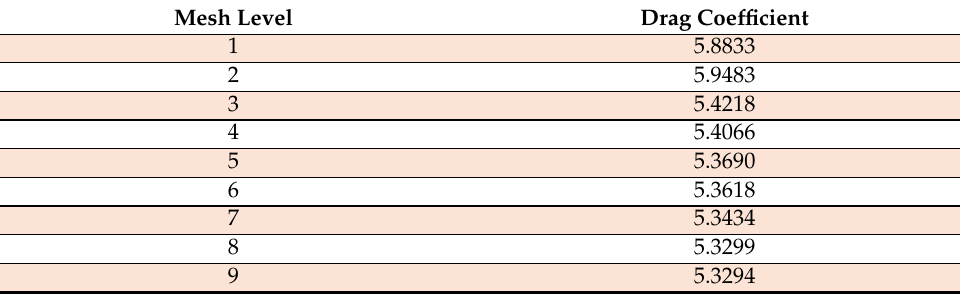
Table 8. Drag coefficient data for Case-IV with